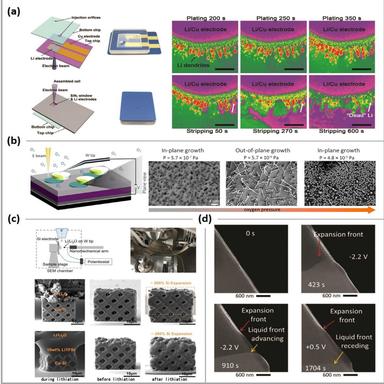
(a) In-situ SEM imaging of lithium plating/stripping on Li/Cu electrodes: The figures and photos of in-situ liquid cell (left side), the SEM images (right side) (scale bar: 20 lm) (Reproduced with permission from ref. Copyright 2017 Wiley–VCH); (b) variant Li plating morphologies under elevated oxygen pressure (Reproduced with permission from ref. Copyright 2018 American Chemical Society); (c) schematic and photo of experiment setup and in-situ SEM images of Cu-Si nanolattice dur